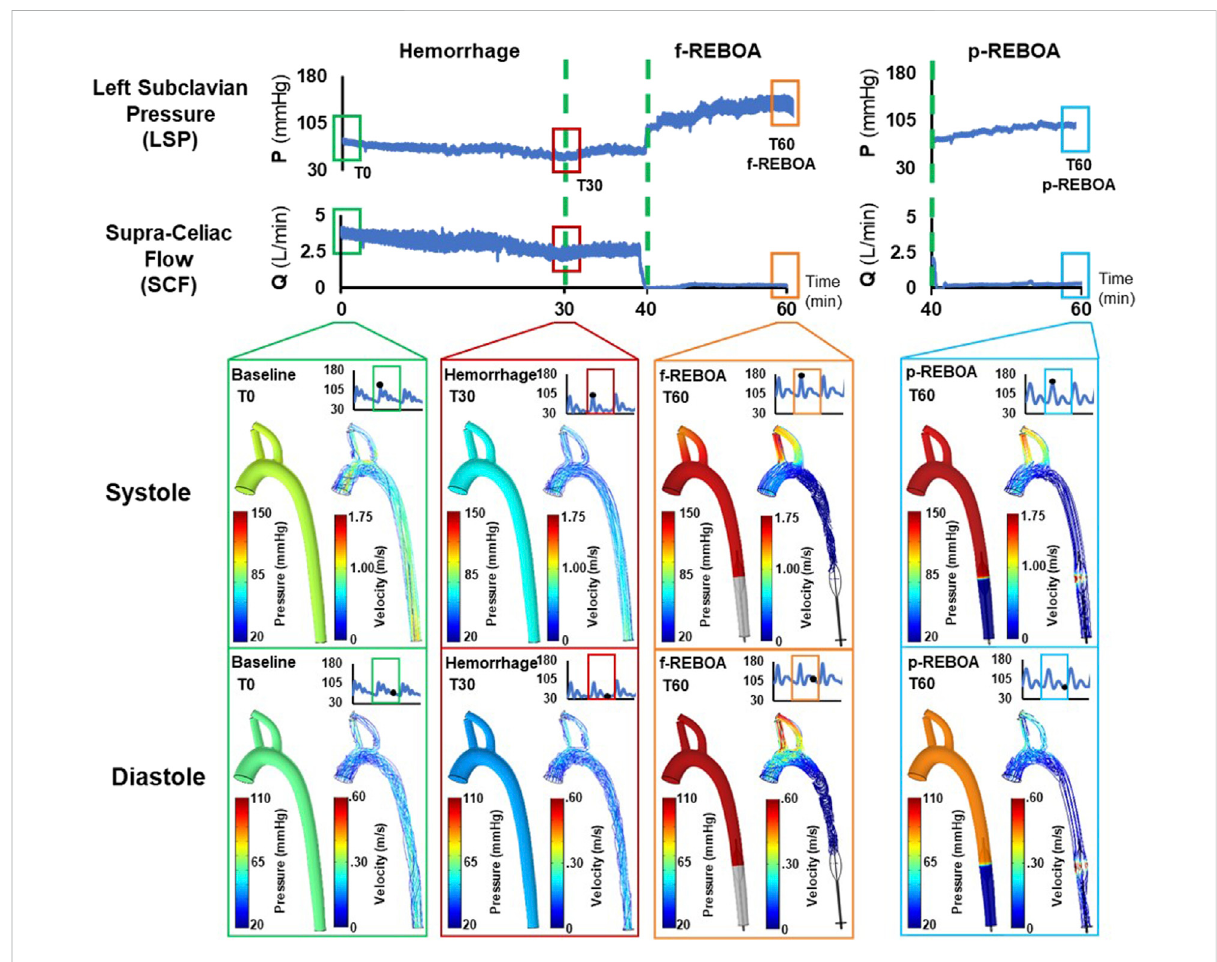
FIGURE 4 Pressure and velocity distributions. Results from the CFD simulations at systole and diastole are illustrated at baseline (T0), the end of 20% hemorrhage (T30), and post f-REBOA and p-REBOA implementation (T60).